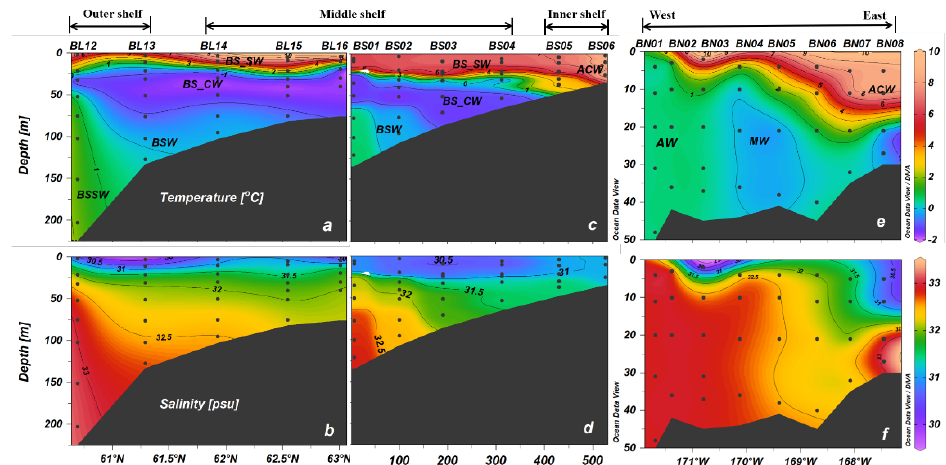
Figure 2. Profiles of temperature and salinity in BL ( a , b ), BS ( c , d ), and BN ( e , f ) sections. BS_SW-Bering Sea Surface Water; BS_CW—Bering Sea Cold Water; BSSW—Bering Sea Slope Water; BSW—Bering Sea shelf Water; ACW—Alaska Coastal Water; AW—Anadyr Water; MW—Mixed Water.